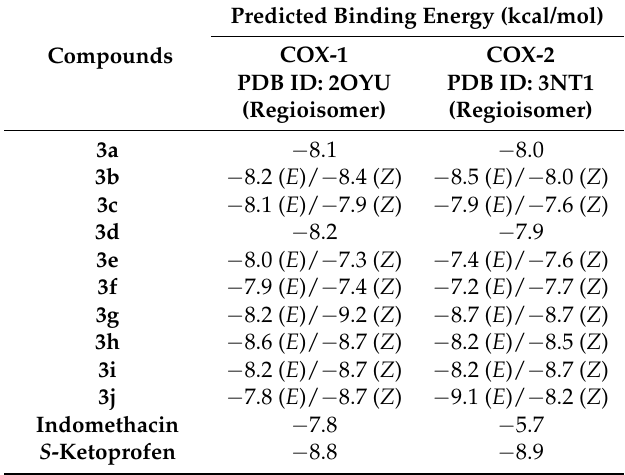
Table 1. Docking results of planned compounds and standard drugs in COX-1 and COX-2 active sites.